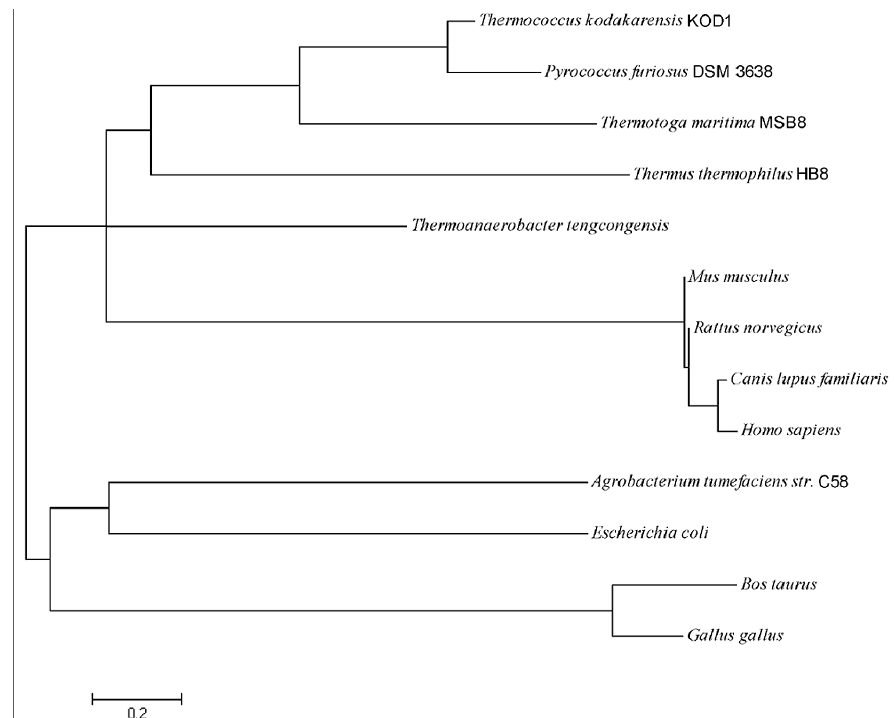
Figure 2. Phylogenetic tree of the known GDPDs. Phylogenetic analysis with Neighbor-joining (NJ) was conducted using MEGA 6.0 software (Hachioji, Tokyo, Japan). GDPD protein sequences that were used for this analysis are XP_536954.2 ( Canis lupus familiaris ), NP_116004 ( Rattus norvegicus ), NP_001032348.1 ( Gallus gallus ), NP_001094611.1 ( Bos taurus ), NP_534690.1 ( Agrobacterium tumefaciens str. C58), EFJ64212 ( Escherichia coli ), NP_057725 ( Homo sapiens ). NP_062526 ( Mus musculus ), WP_004082090 ( Thermotoga maritima MSB8), WP_011229158 ( Thermus thermophilus HB8), 2PZ0_A ( Thermoanaerobacter tengcongensis ), WP_011250348 ( Thermococcus kodakarensis KOD1) and AAL82127.1 ( Pyrococcus furiosus DSM 3638).